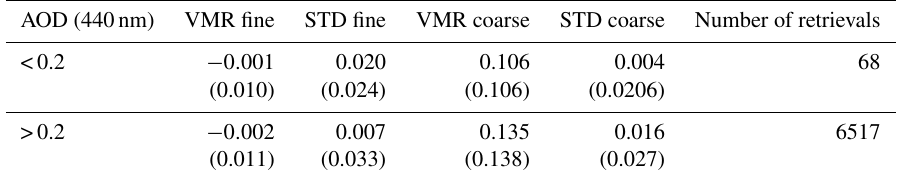
Table 12. Statistics, average values and standard deviations (in parentheses) of the difference in volume median radius (VMR) and width of particle size distribution (STD) retrievals of V2 and V3 for the Kanpur site. The difference is defined as V3 − V2. AOD